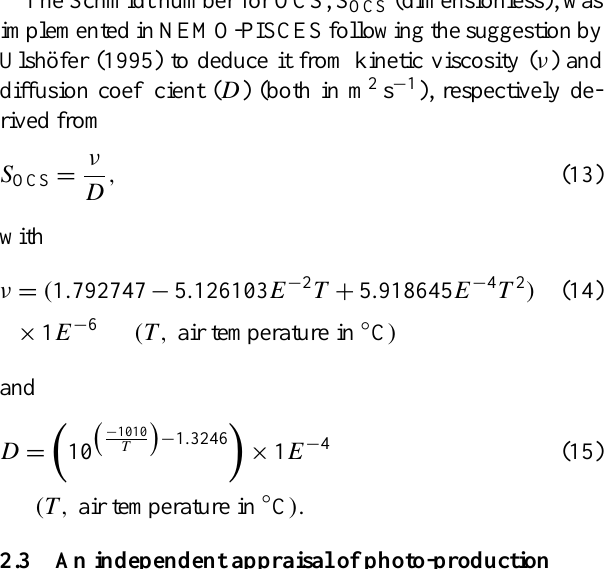
Figure 2. Temperature dependence of hydrolysis rates implemented in NEMO-PISCES. The relationships are represented for pH = 8.2, and taken from Elliott et al. (1989) (E, dashed line) and Kamyshny et al. (2003) (K, solid